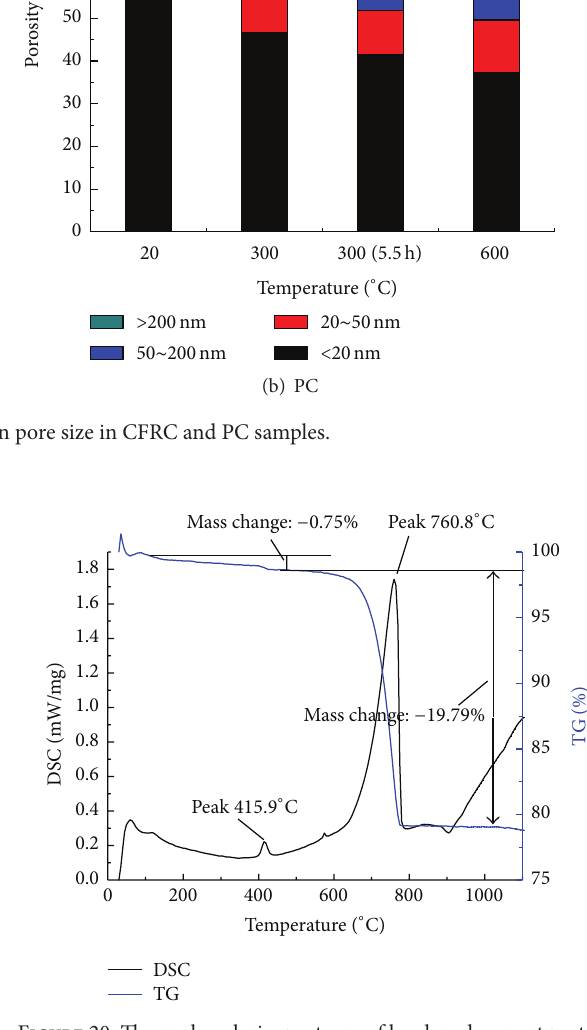
Figure 20: Thermal analysis spectrum of hardened cement paste in